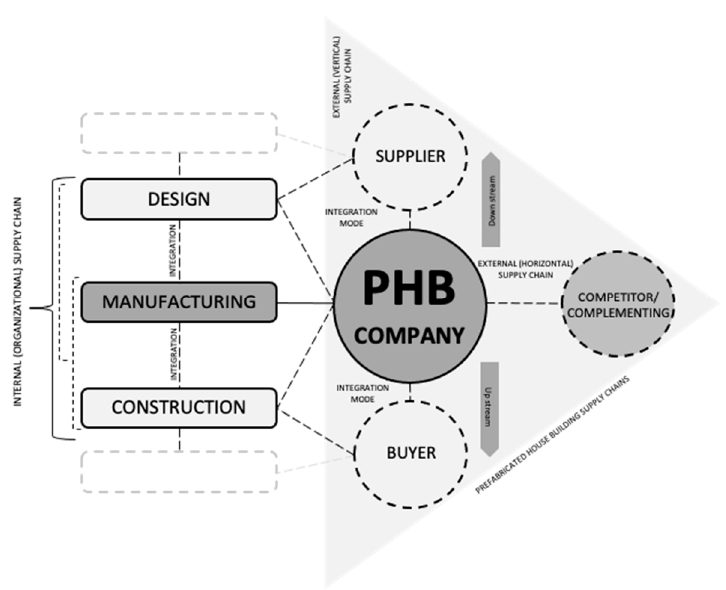
Figure 1. The prefabricated house-building company through supply chain lens [Authors’ concep-